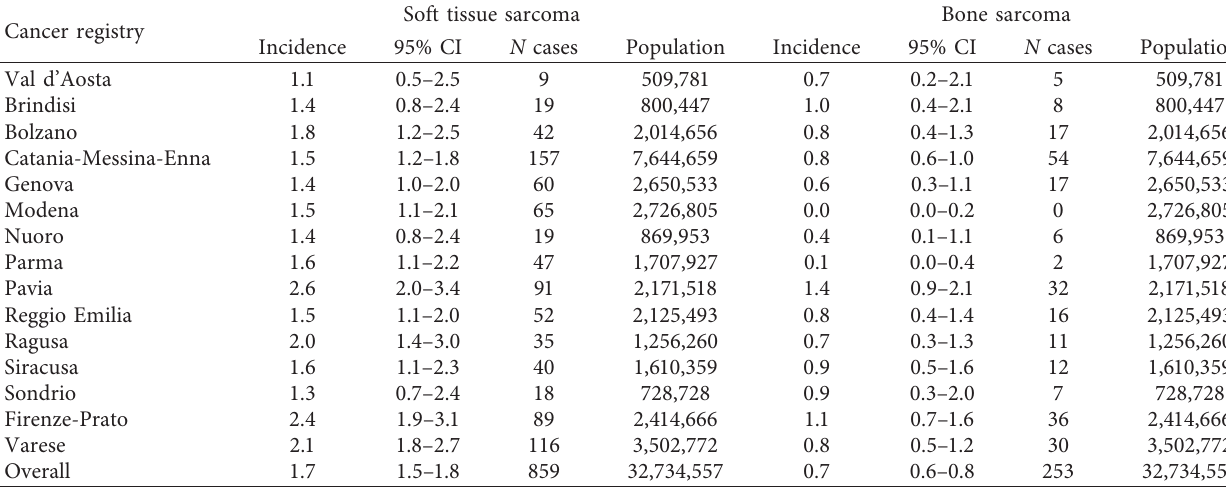
Table 2: Incidence rates (standardised to the age structure of the world population 2000–2025) of soft tissue and bone sarcoma per 100,000 per year by cancer registry.